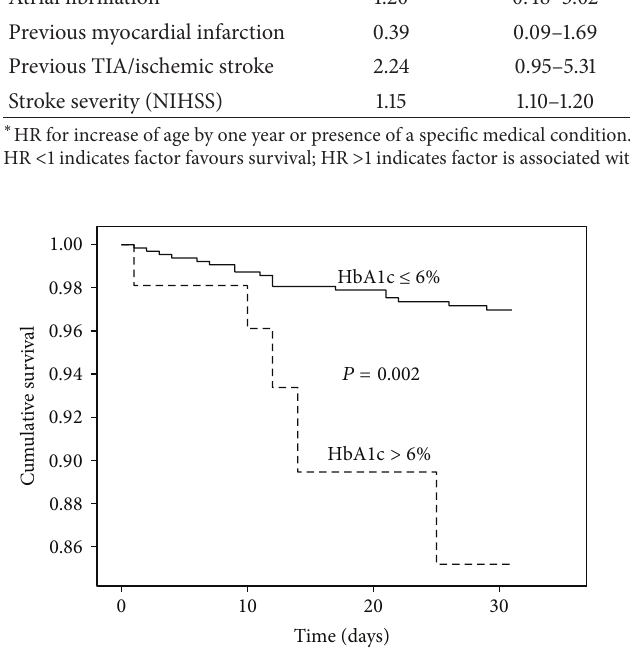
Figure 2: Cumulative survival during the 12-month followup after admission to hospital ( 𝑛 = 98 deaths); stratification according to level of glycated haemoglobin, HbA1c.